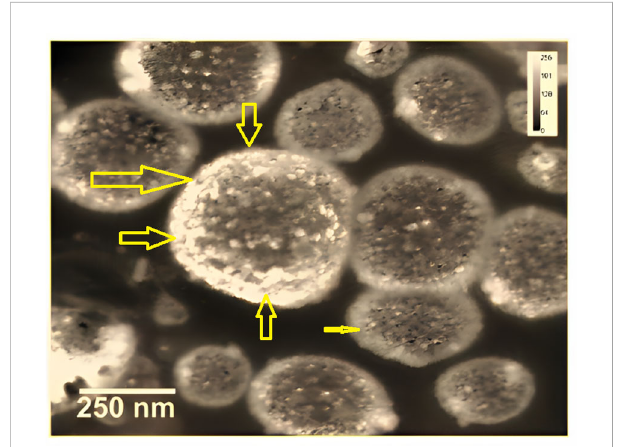
FIGURE 5 Gold nanoparticles coating with DTIC to check drug localization within